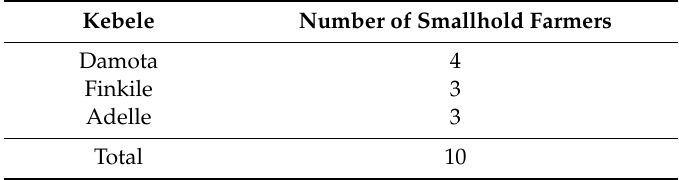
Table 1. Selected kebeles and number of smallhold farmers for the intervention around